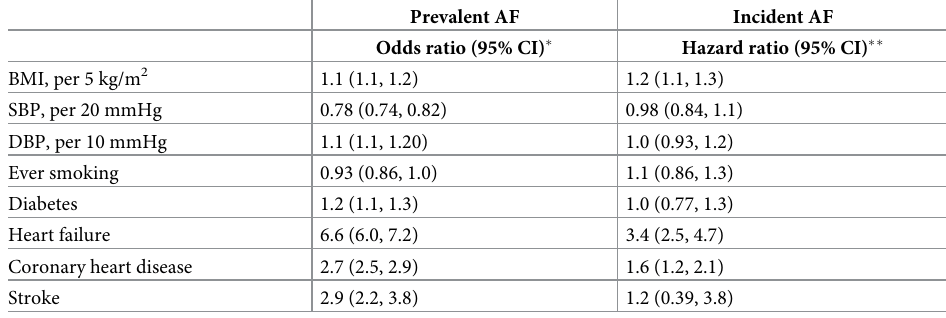
Table 4. Multivariable model for prevalent and incident AF (odds ratio or hazard ratio for covariates), All of Us Research Program 2017–2019.